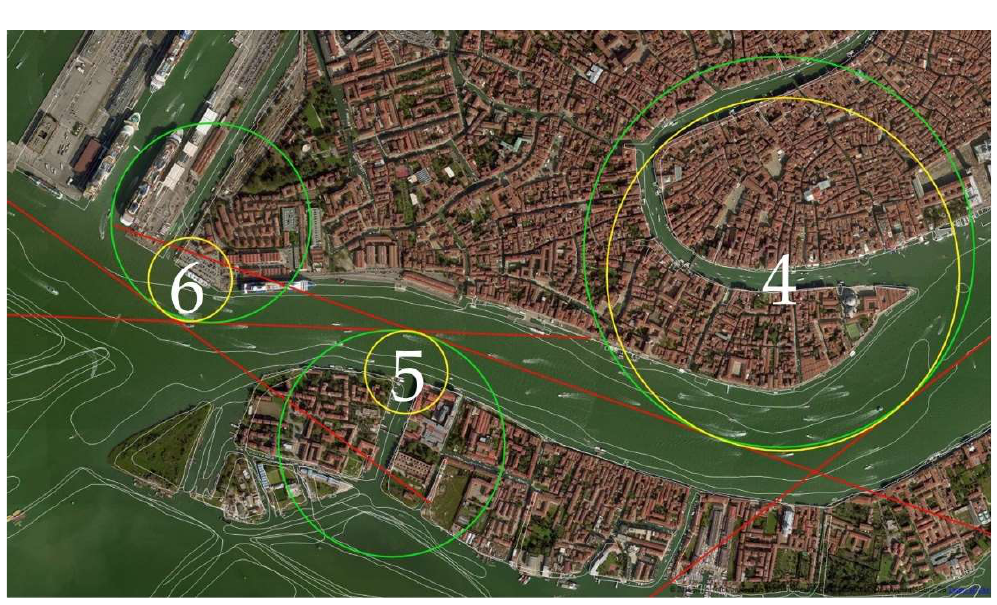
Figure 8. First (green, larger) and last (yellow, smaller) evolution circles in the Venetian Canal.